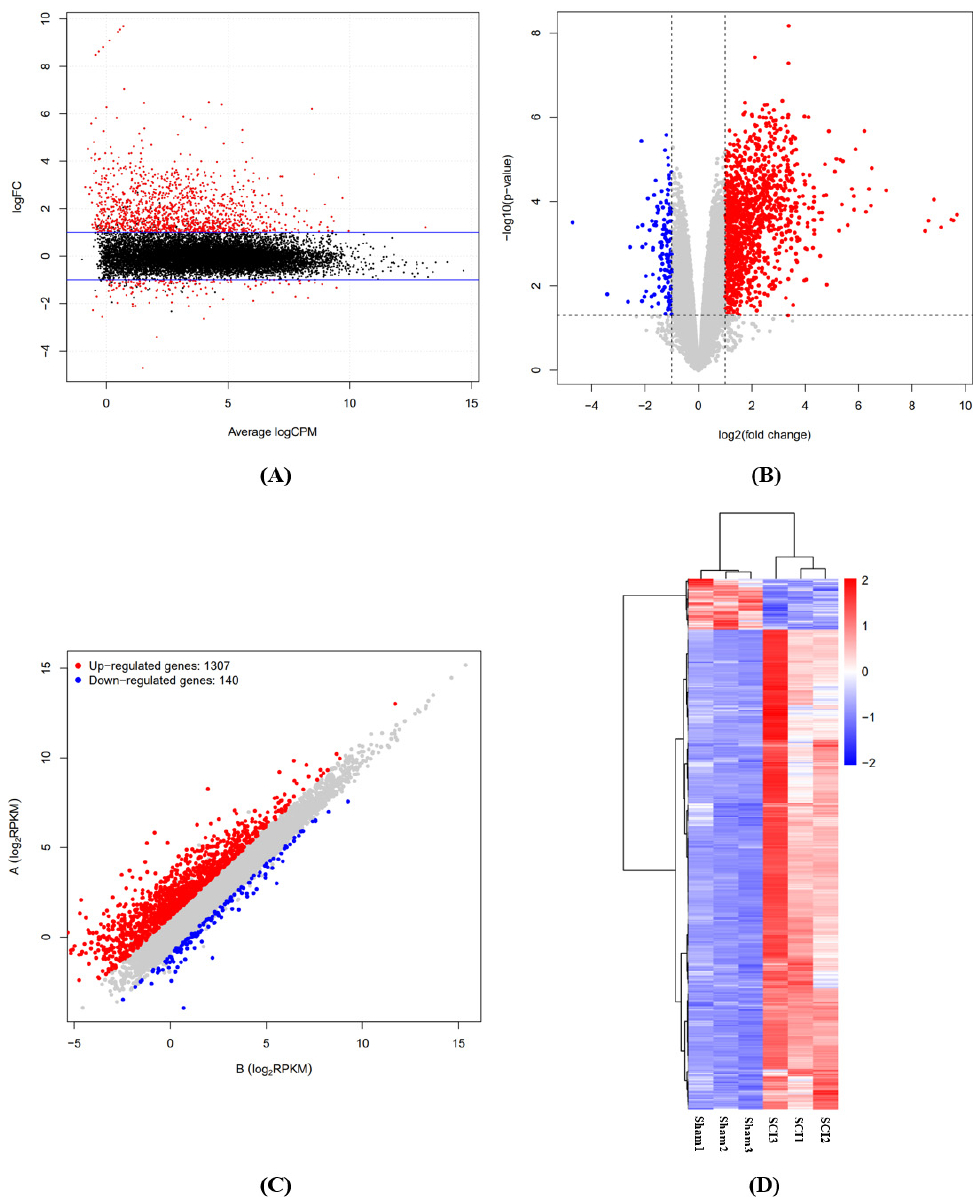
Figure 2. ( A ) MA plot of mRNA expression between the sham group and SCI group. The red dots show >two-fold variation in the expression of mRNAs between the two groups ( n = 3 per group). ( B ) Volcano plot of mRNAs expression between the sham group and SCI group. The red dots indicate up-regulated mRNAs. The blue dots indicate down-regulated mRNAs. ( C ) Scatter plot of mRNA expression between the sham group and SCI group. The red dots indicate up-regulated mRNAs. The blue dots indicate down-regulated mRNAs. ( D ) Hierarchical clustering analysis of mRNAs that were prominently differentially expressed ( p -value ≤ 0.05 and fold-change ≥ 2) between the sham group and SCI group.